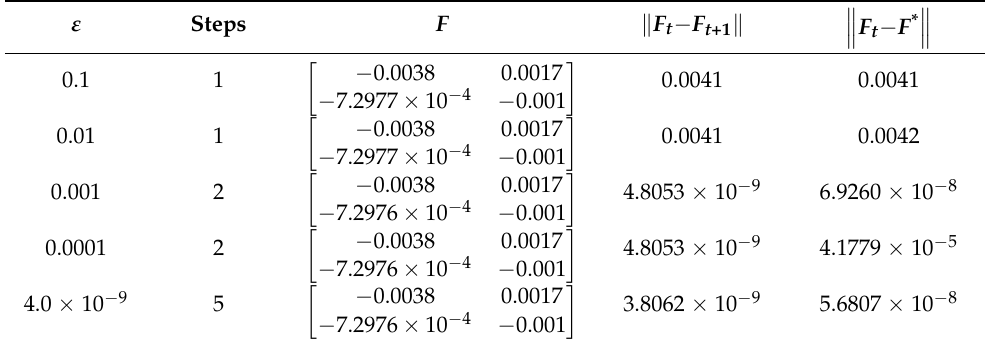
Table 2. Convergence details of Simulation